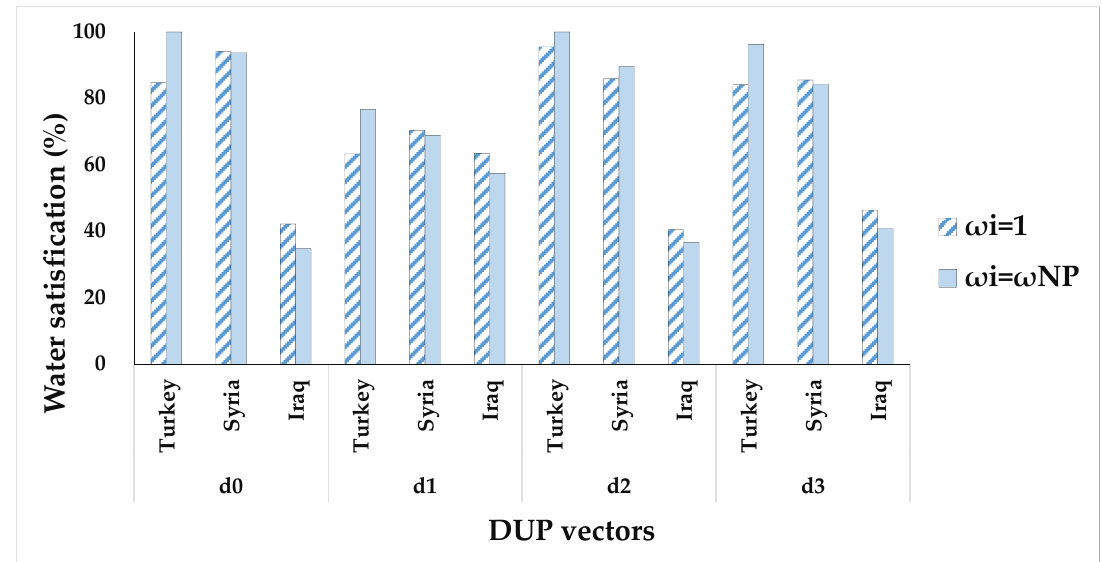
Figure 3. Water satisfactions (%) of three agents under two Nash bargaining solutions with considering different DUP vectors and two bargaining weights of ω Rc and ω Ra . d0 indicates that the agents’ DUP vector is 0; d1 indicates that the agents’ DUP vector is determined by MTBT; d2 indicates that the agents’ DUP vector is determined by MRDC; d3 indicates that the agents’ DUP vector is determined by MENP.